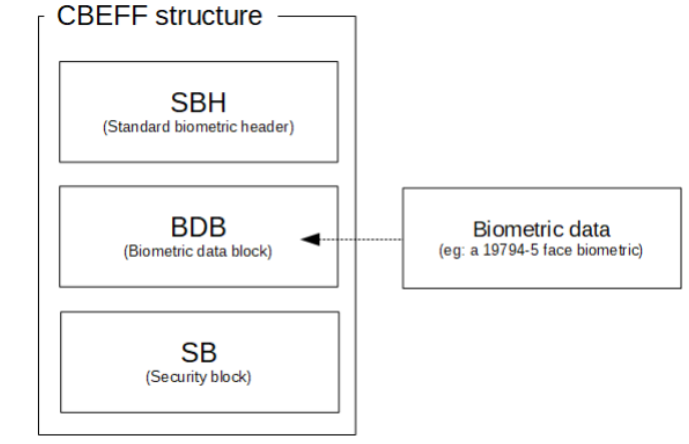
Figure 2 – CBEFF basic data structure (Thevenot et al, 2001) Рис. 2 – CBEFF базовая структура данных (Thevenot et al, 2001) Слика 2 –Основна структура података CBEFF (Thevenot et al,